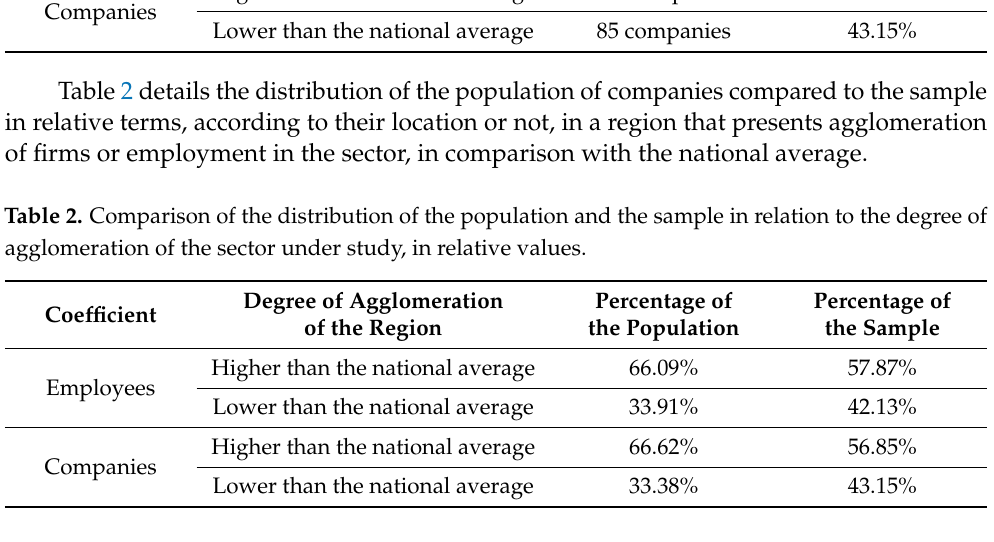
Table 2 details the distribution of the population of companies compared to the sample